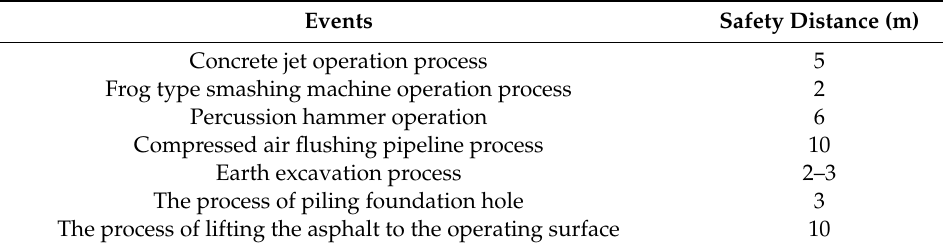
Table 1. List of safety distance statistics in specification.